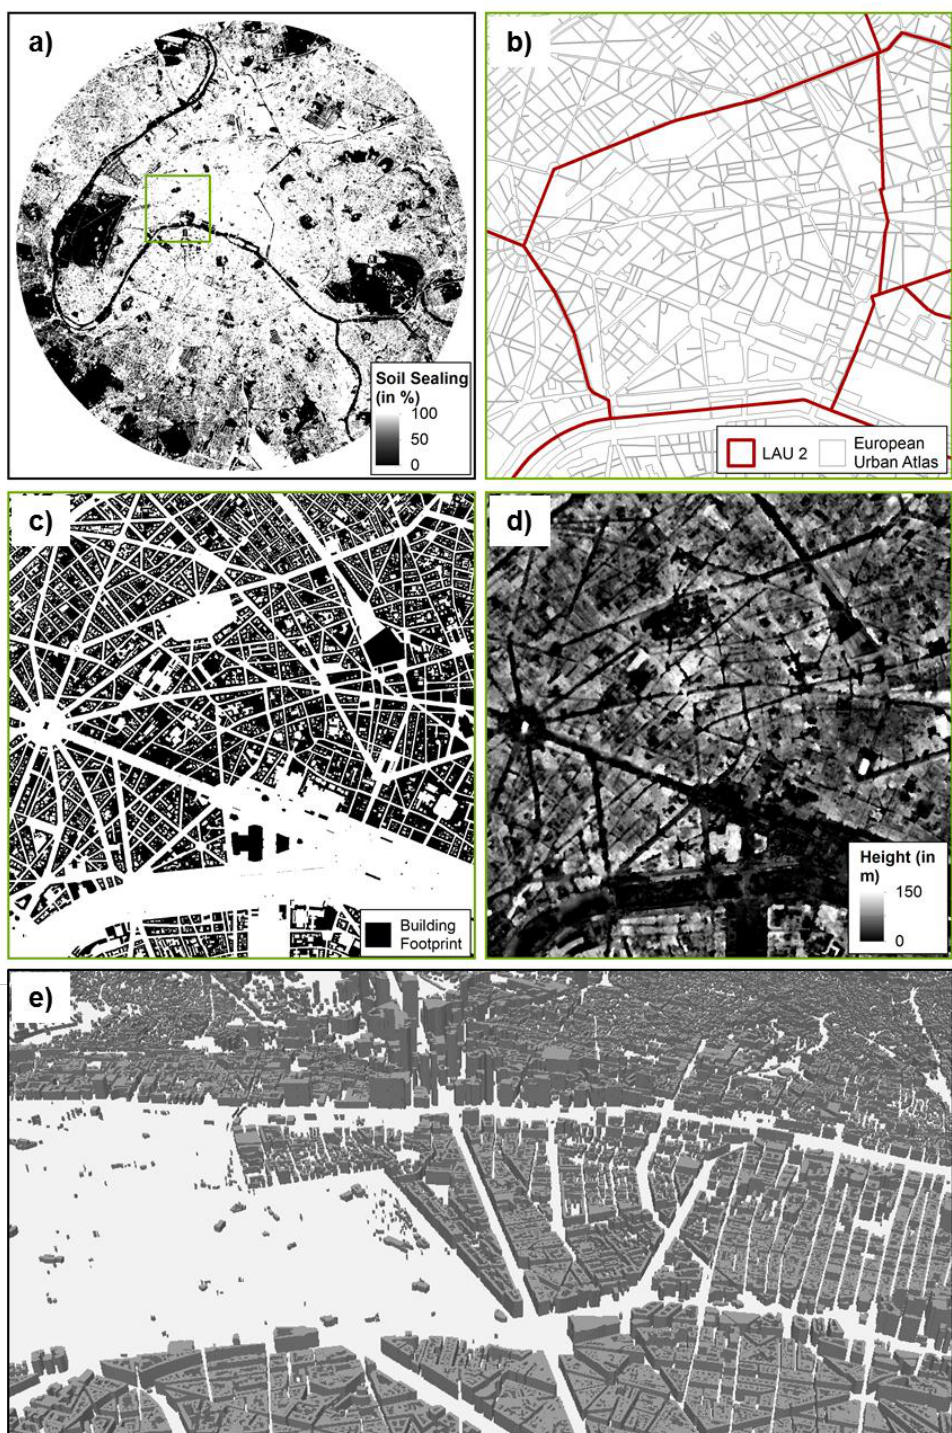
Figure 1. Spatial input data: ( a ) Soil Sealing Layer; ( b ) Block units of the European Urban Atlas and Local Administrative Units (LAU); ( c ) Building footprints from OSM (comparable to the building footprint of the UKMap dataset, respectively); ( d ) Normalized digital surface model from Cartosat-1 satellite data; and ( e ) Perspective view of the derived 3-D city model, exemplified for Paris.